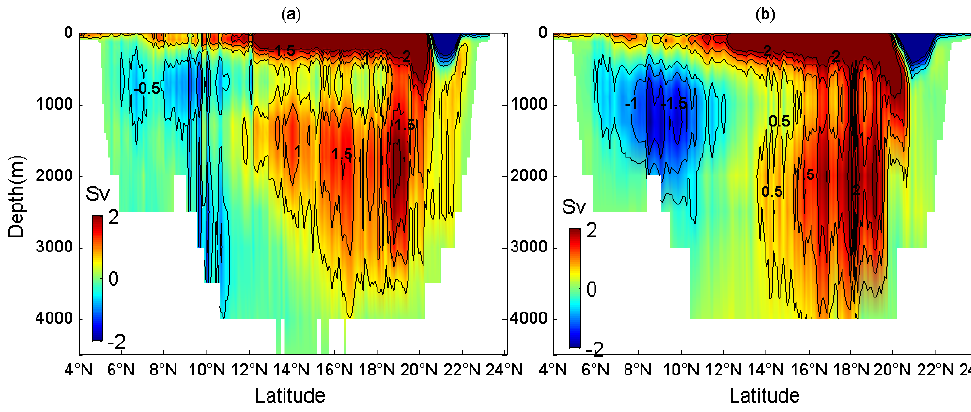
Figure 1. SCSMOC averaged from 2004 to 2010 based on GLBa0.08 (a) and GLBu0.08 (b) .